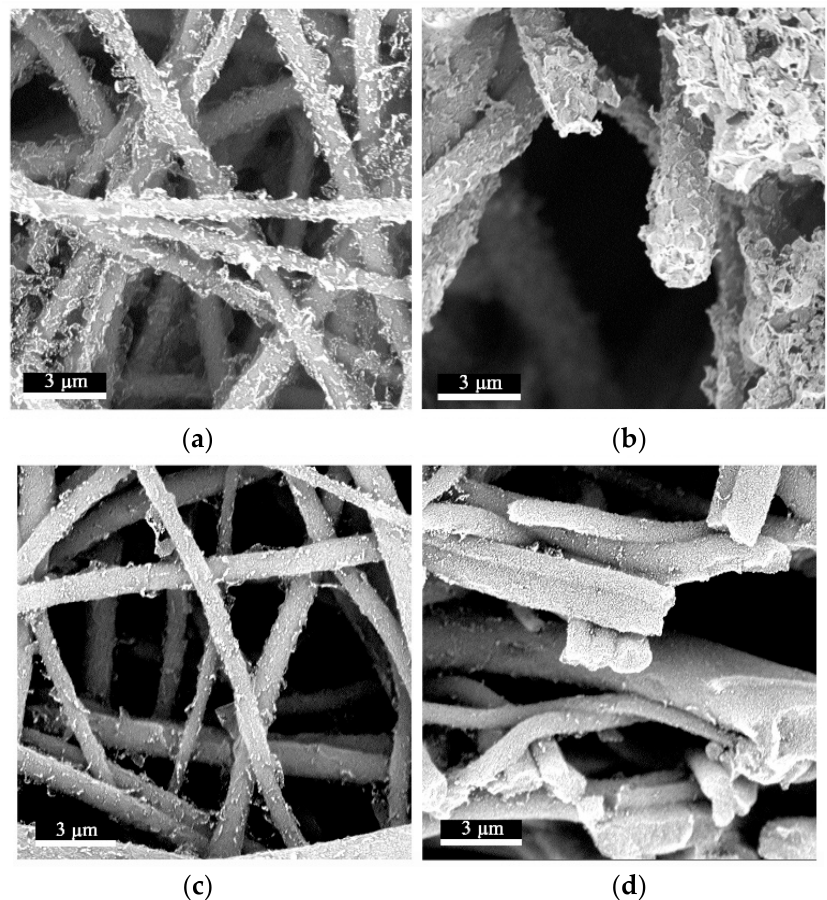
Figure 5. The surface micromorphology of anchored graphene fibers: ( a ) plan view of nanofibers after anchoring rGO; ( b ) cross ‐ sectional view of nanofibers after anchoring rGO; ( c ) plan view of nanofibers after anchoring GO; ( d ) anchor cross ‐ section of nanofibers after GO.